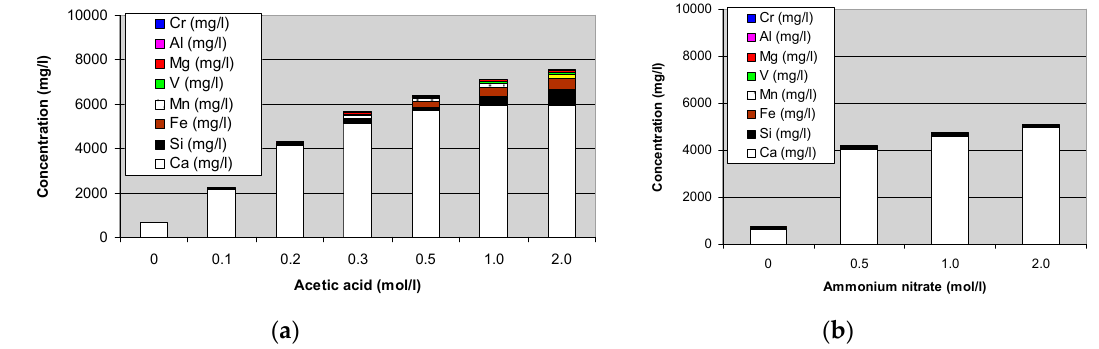
Figure 7. Selective leaching of calcium and other elements from steel converter (BOF) slags at ambient conditions using acetic acid ( a ) and ammonium nitrate ( b ) solutions with different strengths.